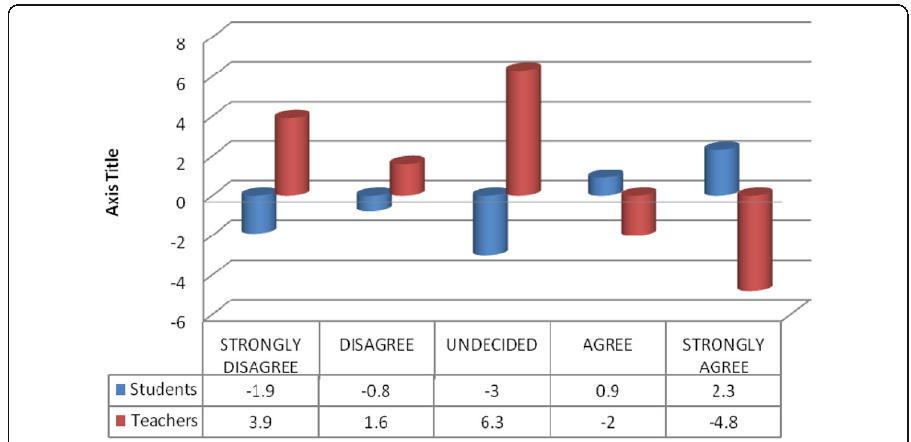
Fig. 3 Standardized residuals of the teachers-learners ’ perceptions towards explicit grammar instruction and corrective